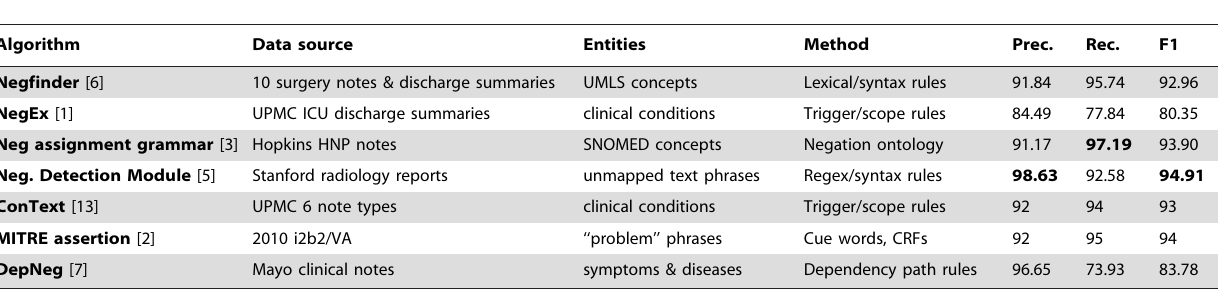
Table 1. Extensive successful previous work on negation detection in clinical